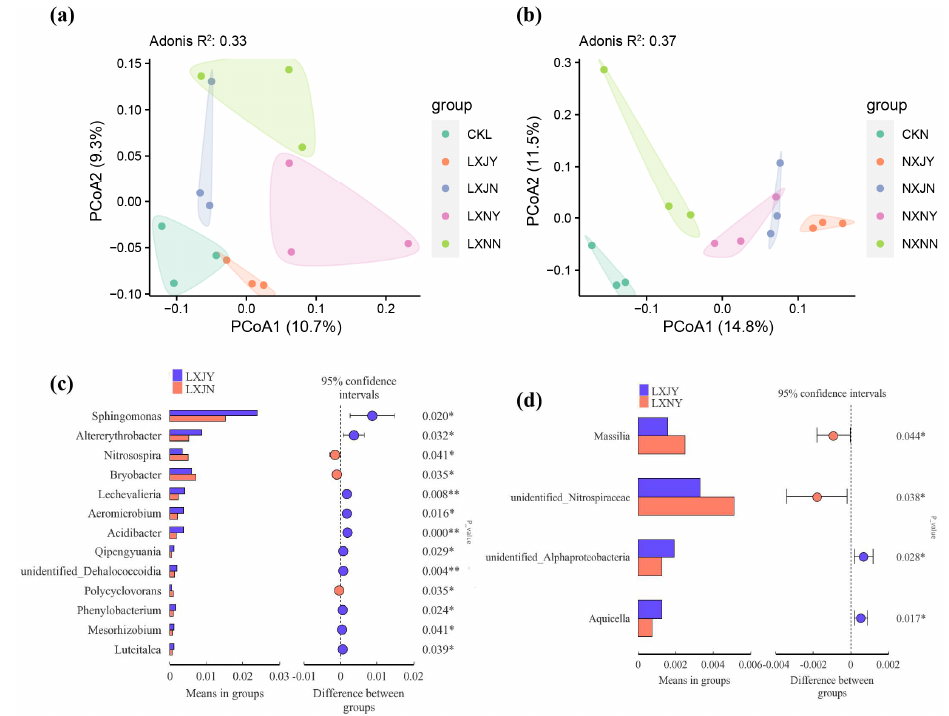
Figure 6. Effects of D74 agents and maize rotation on bacterial community structure. The PCoA based on Bray–Curtis distance with Adonis test (( a ) added O. cumana , ( b ) unadded O. cumana , p < 0.05). Analysis of species with significant difference in genus level (( c ) maize rotation, ( d ) added D74 agents, T-test, p < 0.05). Critical level of significance of constructs at * 10%, ** 5%.